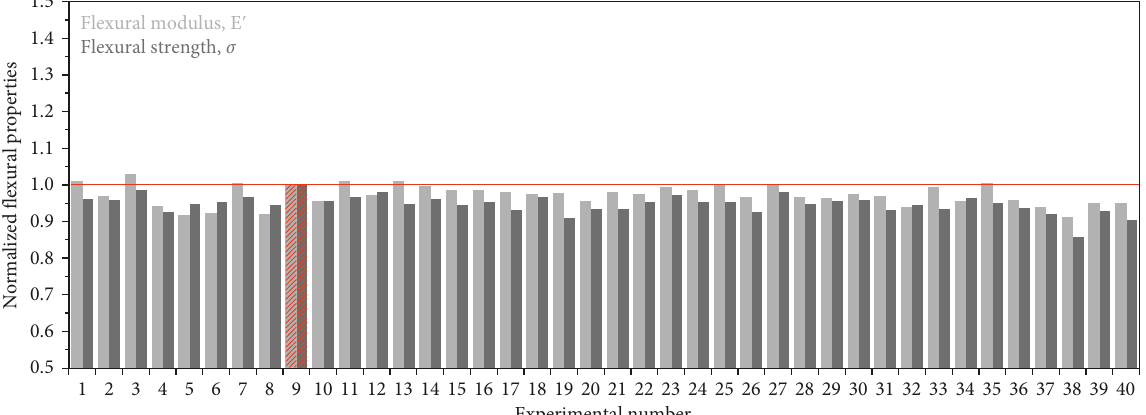
Figure 8: Normalized flexural properties of sintered parts compared to exp. N ° 9. The red line corresponds to exp. N ° 9, which represents the parameters recommended by the supplier.